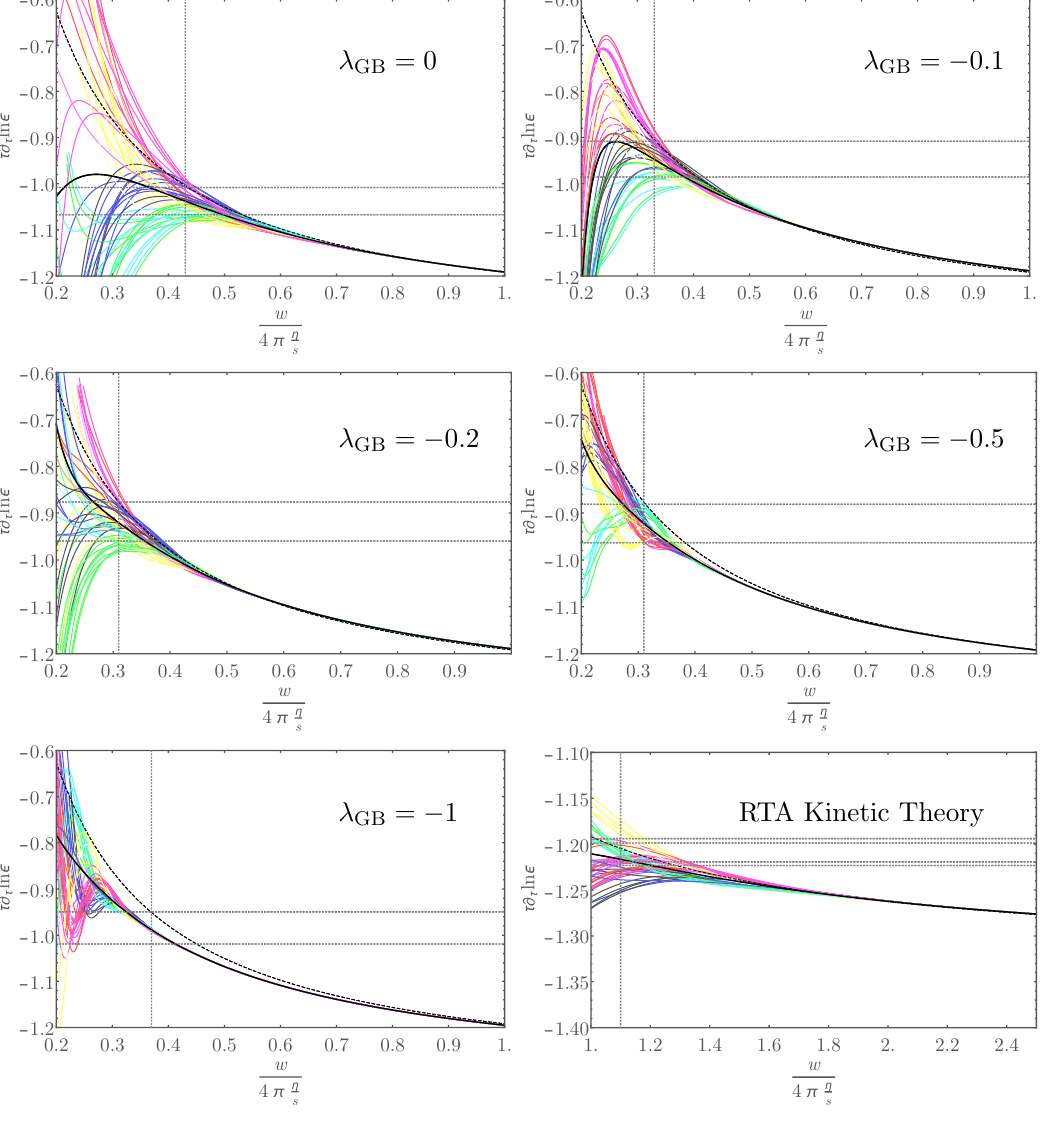
Figure 4 . Logarithmic derivative of the energy density as a function of the viscosity-rescaled inverse gradients for di(cid:11)erent values of (cid:21) GB . In all panels, the thick solid lines are the result of the resummation of the hydrodynamic series, while the dashed line correspond to the (cid:12)rst order hydrodynamic prediction. The thin coloured lines correspond to adding to the resummation the discontinuities de(cid:12)ned in eq. (4.2) with arbitrary coe(cid:14)cients. The vertical dotted line indicates the rescaled hydrodynamization time w hyd s , the horizontal lines give the corresponding R = (1 (cid:6) 4 (cid:25)(cid:17) 0 : 1) R j as displayed in table (1) (including its uncertainties for RTA). Every curve corresponding w hyd to evolution in a Holographic theory is insensitive up to 2% to the choice of the Pad(cid:19)e order N used for w > 0 : 3. For the case of N = 4 there is no visible change for the entire region plotted. All RTA curves plotted were insensitive to N at the level of